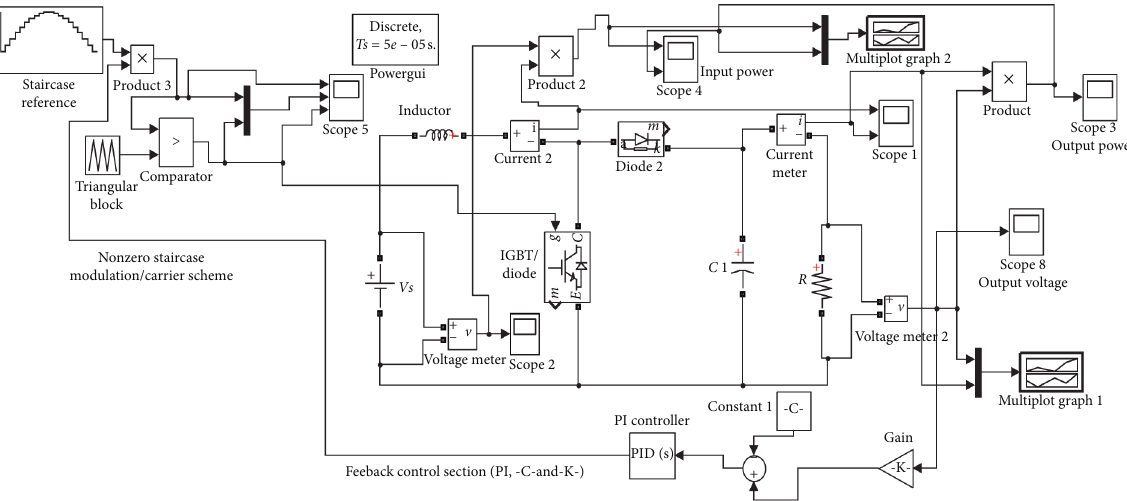
Figure 7: MATLAB/simulink model of the proposed system.